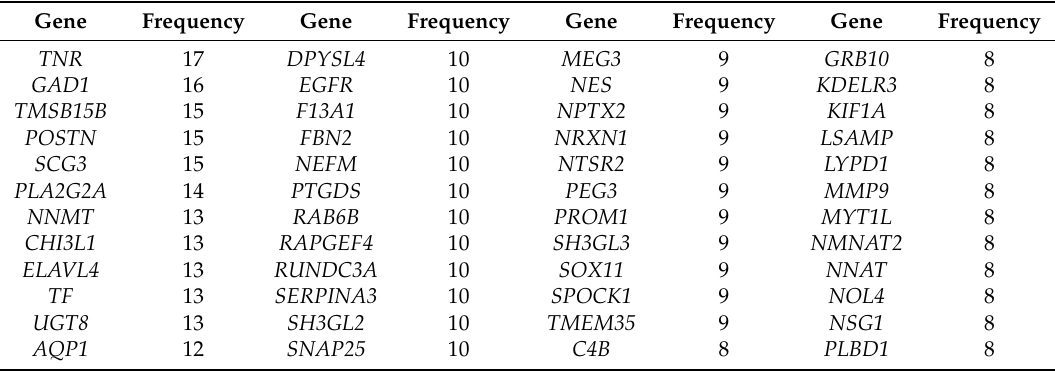
Table 1. Frequency analysis of important genes in the 27 deep-learned network nodes at the top hidden layer. Only the top 100 frequently occurring genes are listed for